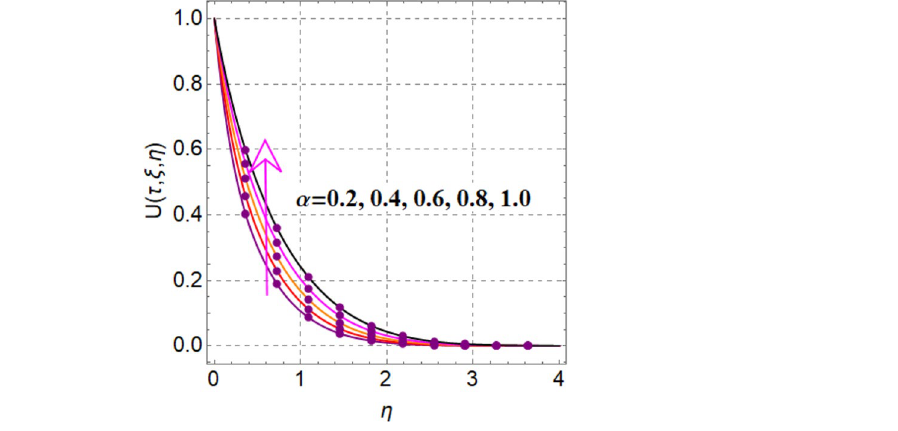
Figure 2. U (τ , ξ , η) via α .